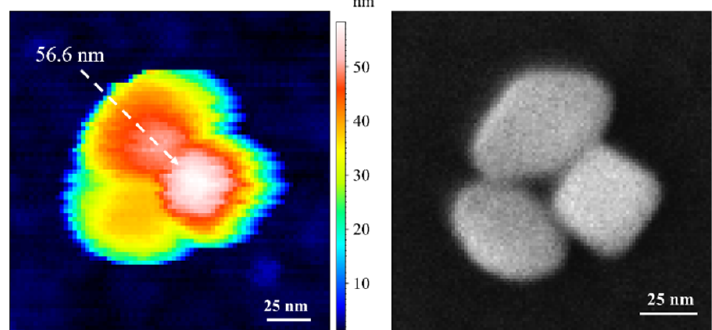
Figure 6. ( Left ): AFM image of 3 agglomerated TiO 2 NPs. The arrow indicates the TiO 2 NPs in standing orientation ( ③ ) with the AFM height of 56.6 nm, and ( right ): correlative SEM image of the same agglomerated TiO 2 ‐ NPs with a measured D fmin for the right particle in orientation ③ of 40.9 nm.